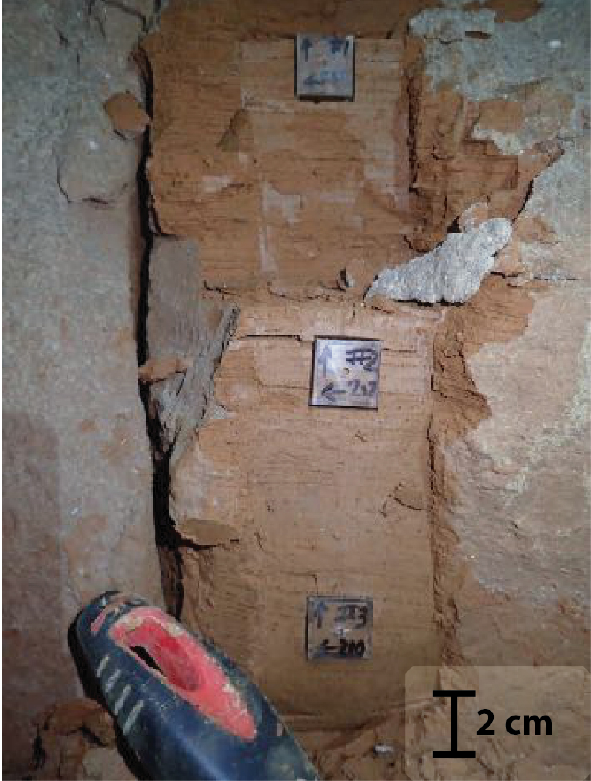
Figure 4. Example of clay sampling for the paleomagnetic study. Location at the entrance shaft (highest elevation of every samples, ∼ 580ma.s.l.; Leicasse cave system, Site 2, Fig.